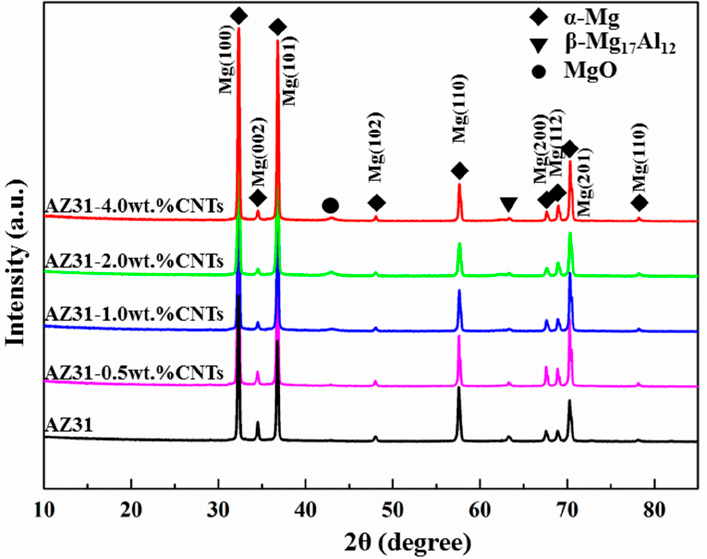
Figure 2. XRD (X-ray diffraction) patterns (taken perpendicular to the extrusion direction) of the AZ31 magnesium alloy and its nanocomposites. Table 3. Texture results of AZ31 and its nanocomposites (taken perpendicular to the extrusion direction) based on X-ray diffraction.